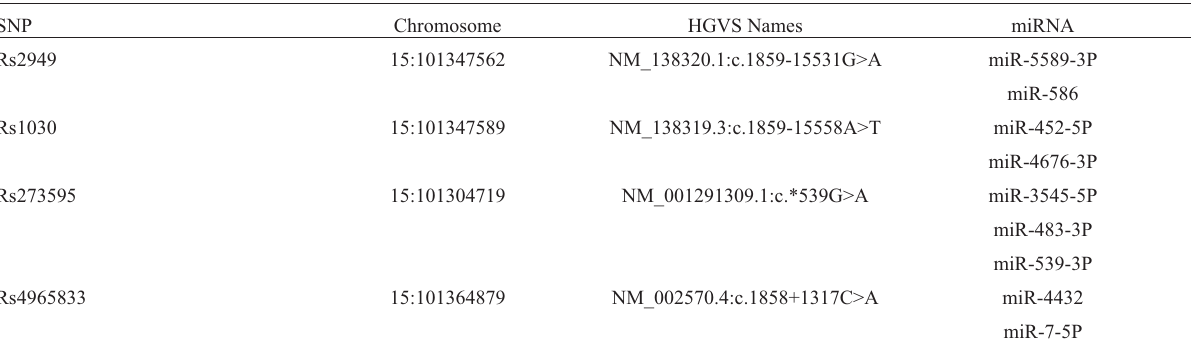
Table 2 - SNPs located in the PACE4 gene 3’-UTR and the predicted